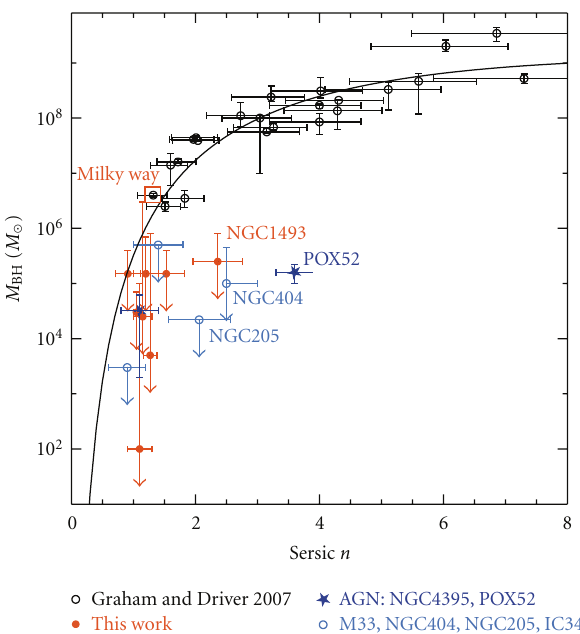
Figure 2: The mass of the BH against the Srsic index of the host bulge or disk. We plot the objects as listed in the text. The largest outliers are NGC205 (with n = 2 . 05), POX52 ( n = 3 . 6), NGC404 ( n = 2 . 5), and NGC1493 ( n = 2 .